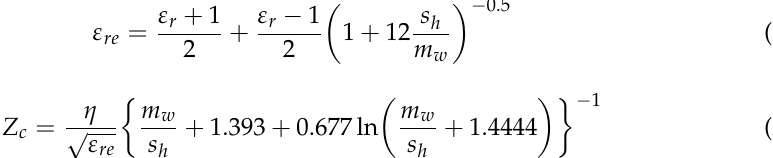
Figure 1c: a 1 (outer diameter of the outer circle), b 1 (inner diameter of the outer circle), c 1 (outer diameter of the inner circle), d 1 (inner diameter of the inner circle), and e 1 (size of the splits in each circle). As shown in Figure 1d, the geometry of the SC-SRR is described by five parameters: a 2 (outer length of the outer square), b 2 (inner length of the outer